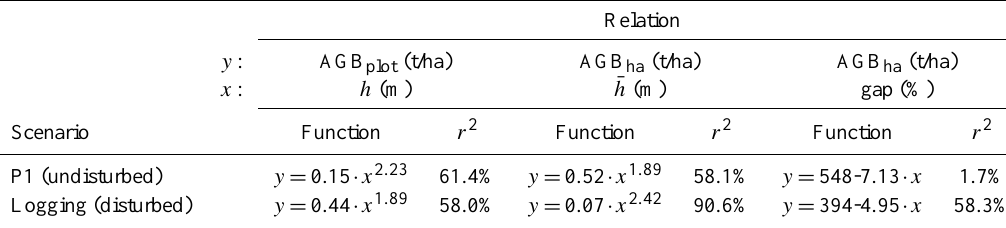
Fig. 3. Comparison of the normalised frequency distribution of above-ground life biomass for (A) undisturbed forests (site P1) with (B) field data from the large-scale inventory of 52ha in Lambir, Sarawak, Malaysia (Yamakura et al., 1996) for both 0.04 and 1ha-scale. P1 simulations were already plotted in Fig. 1b. P1 simulations cover 100ha with annual output over 400yr ( n = 40100), while the Lambir field data cover one inventory over 52ha ( n = 52). The larger data ensemble of the simulations therefore enable a finer discretisation of AGB than the Lambir field data ( 1 (AGB) = 10 and 100t/ha, respectively). Table 2. Regression functions between above-ground life biomass (per plot or as ha-mean) and maximum height of trees or gap fraction (gap: maximum height of plot < 25m) of site for undisturbed site P1 or average over all 24 logging scenarios. All regressions are significant ( P < 0 . 01).